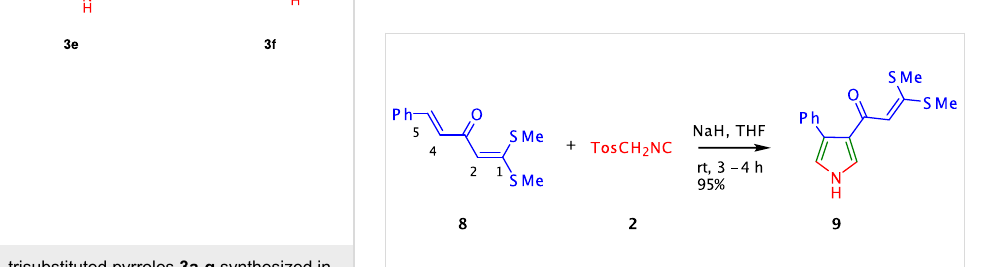
Figure 1: Structure of 2,3,4-trisubstituted pyrroles 3a-g synthesized in this study.